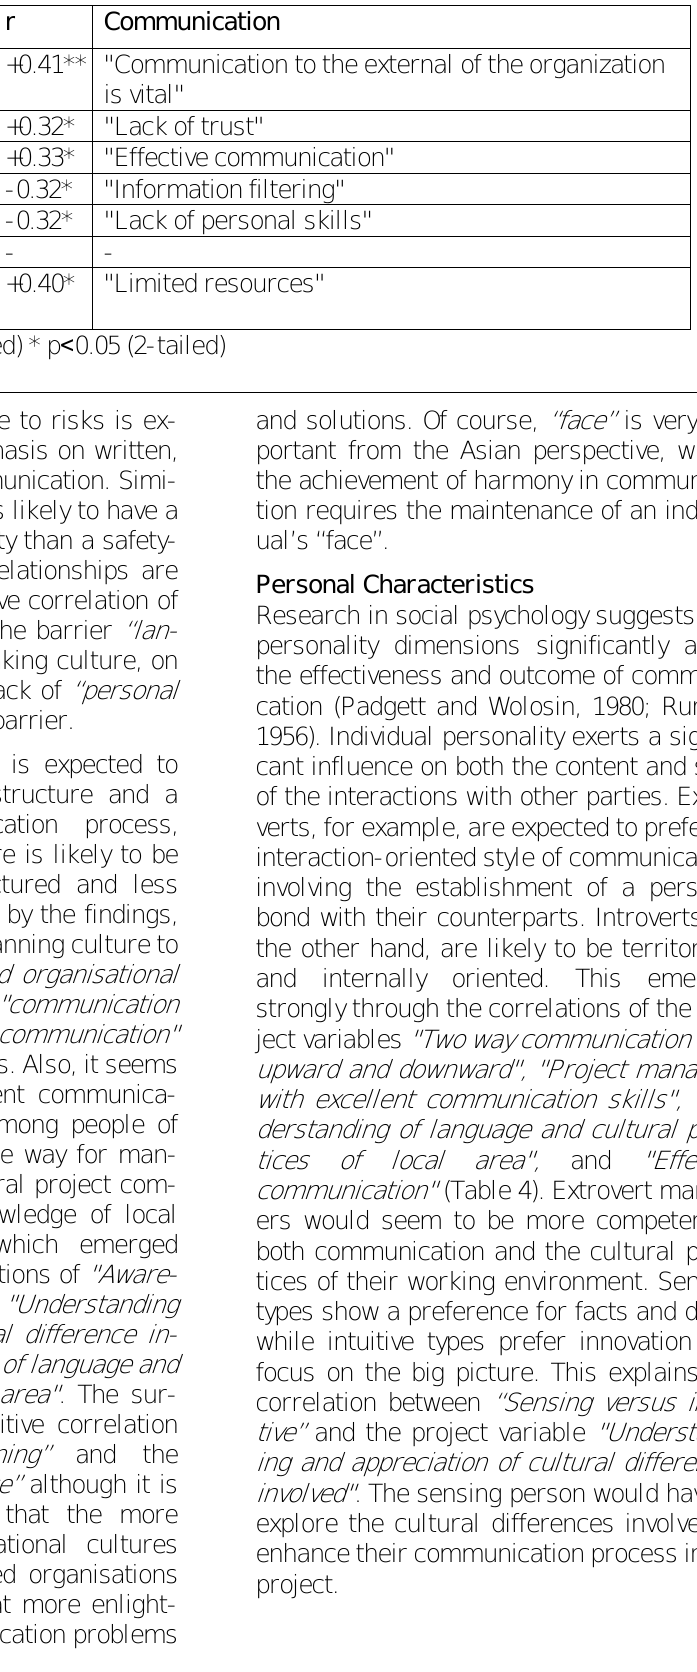
Table 3: Correlations between Organization Cultures and